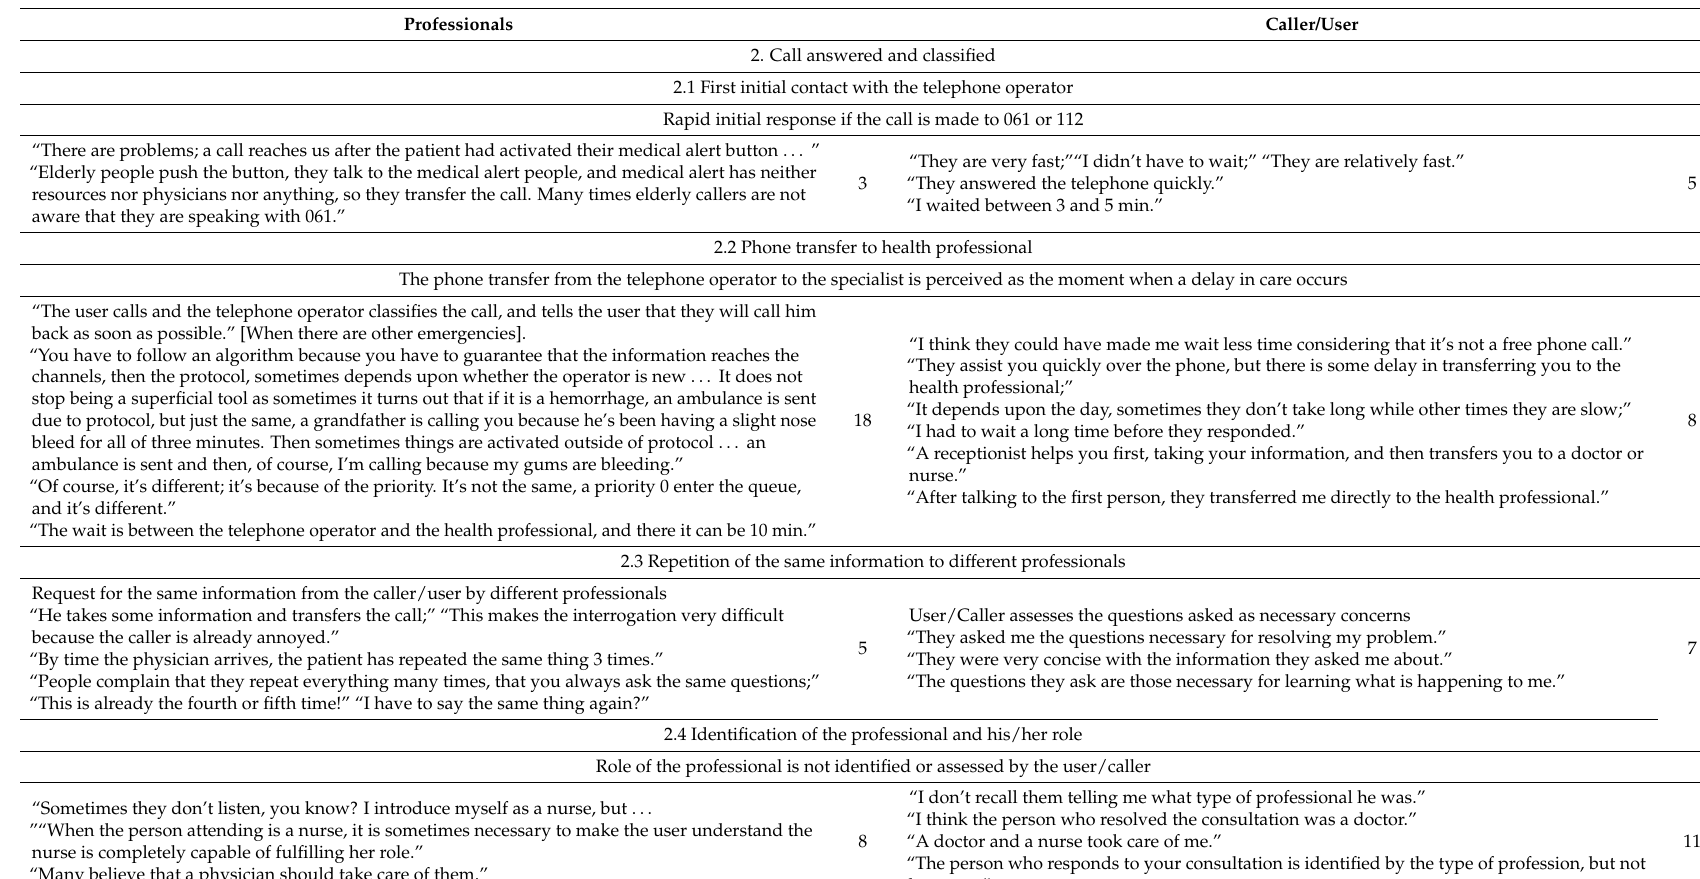
Table 3. Subprocess 2. Telephone Support and